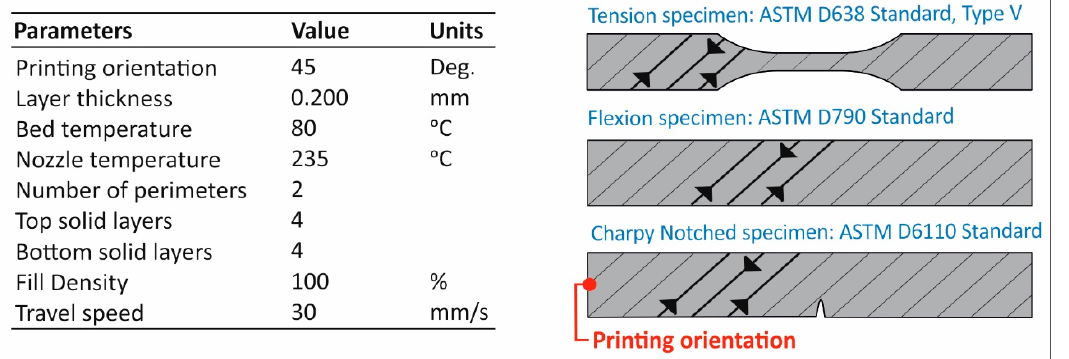
Figure 3. Parameters employed in the study for the construction of the FFF 3D printed specimens.